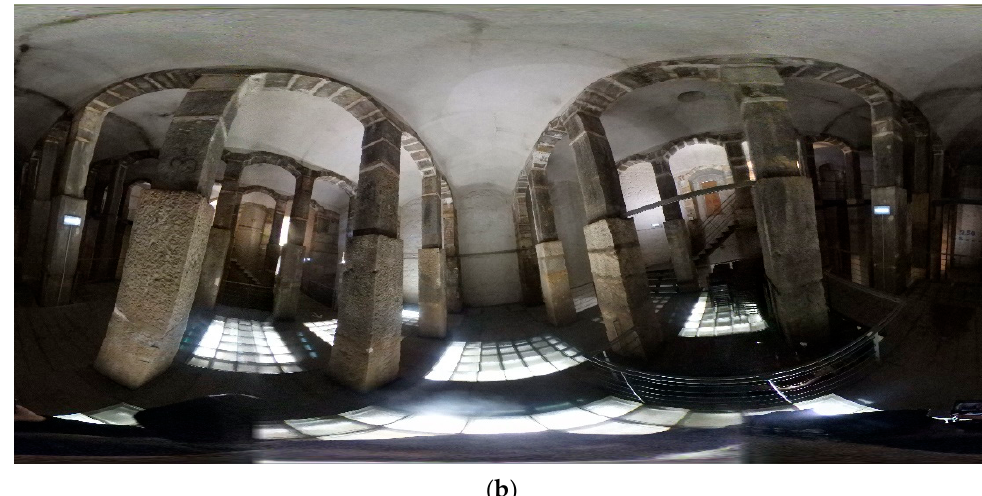
Figure 8. ( a ) Nikon KeyMission 360; ( b ) Image captured with spherical camera.